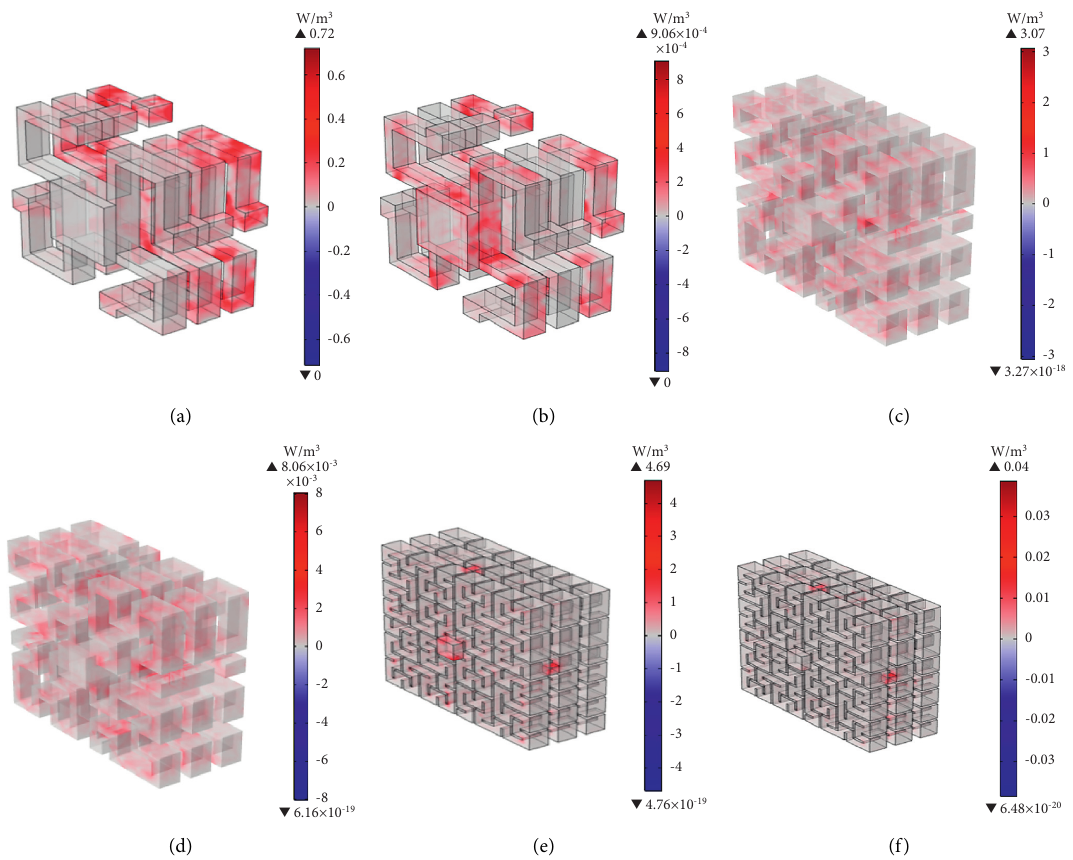
Figure 7: Overall coiled channel thermoviscous power consumption density distributions of each order metamaterial structure. (a) 214Hz overall thermoviscous power consumption density distribution. (b) 400Hz overall thermoviscous power consumption density distribution. (c) 119Hz overall thermoviscous power consumption density distribution. (d) 200Hz overall thermoviscous power consumption density distribution. (e) 69Hz overall thermoviscous power consumption density distribution. (f) 150 Hz overall thermoviscous power con- sumption density